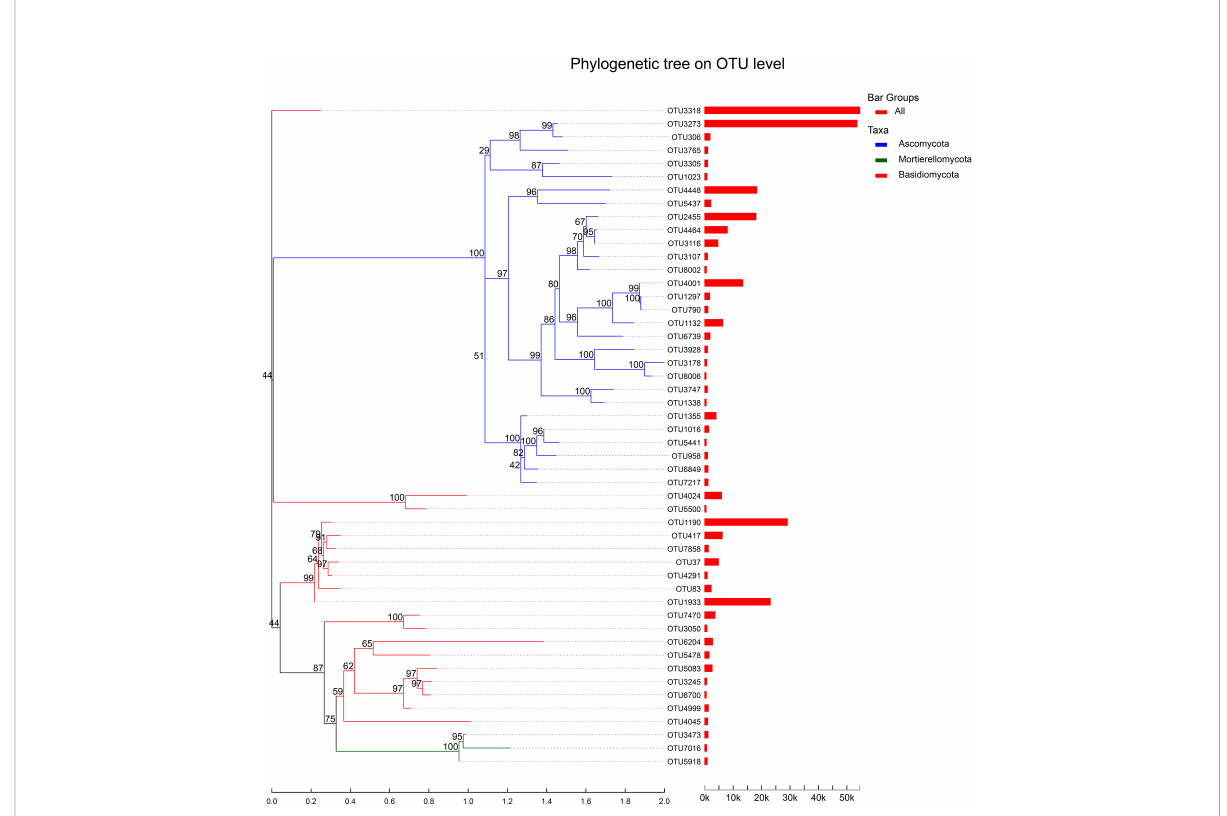
FIGURE 7 System evolution tree. Each branch represents each OTU, and the branch is colored according to the advanced Phylum level of the species. The length of the branch is the evolutionary distance between the two species, namely the degree of species difference. The column shows the proportion of Reads in different